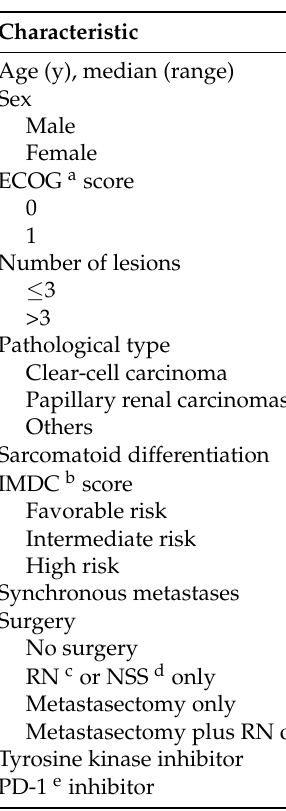
Table 1. Patient baseline characteristics.